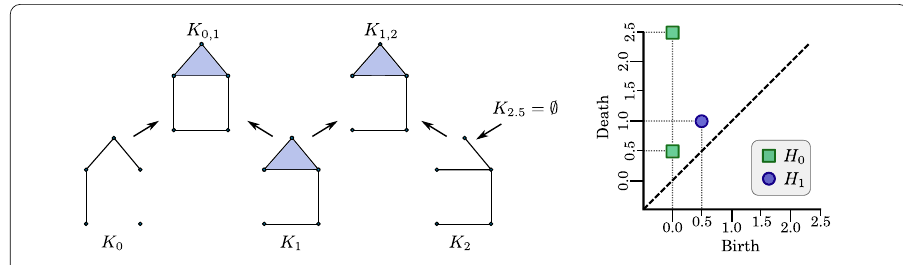
Figure 2 Example application of zigzag persistence to study changing topology of simplicial complex sequence. This example shows the sequence of simplicial complexes with intermediate unions and corresponding time stamps on the left and on the right the resulting zigzag persistence diagram on the right for dimension 0 and 1 as H 0 and H 1 ,